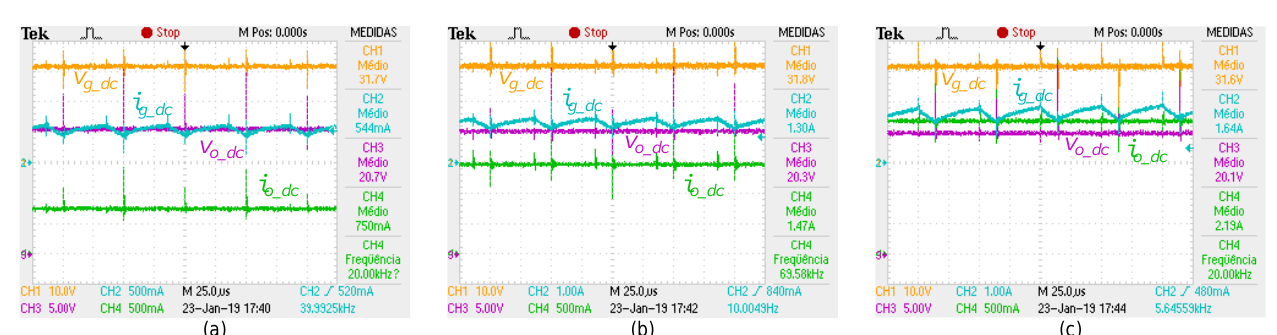
Figure 9. Obtained experimental results for Case 3 – load without the input ac-dc converter supplied by dc